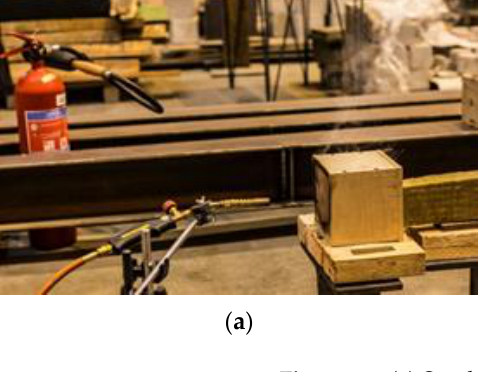
Figure 10. ( a ) Smoke coming from the inside of the sample cessation of exposure to fire; ( b ) Tem- perature distribution in the corner of the straw sample corner put in the wooden frame for time t = 16 min.